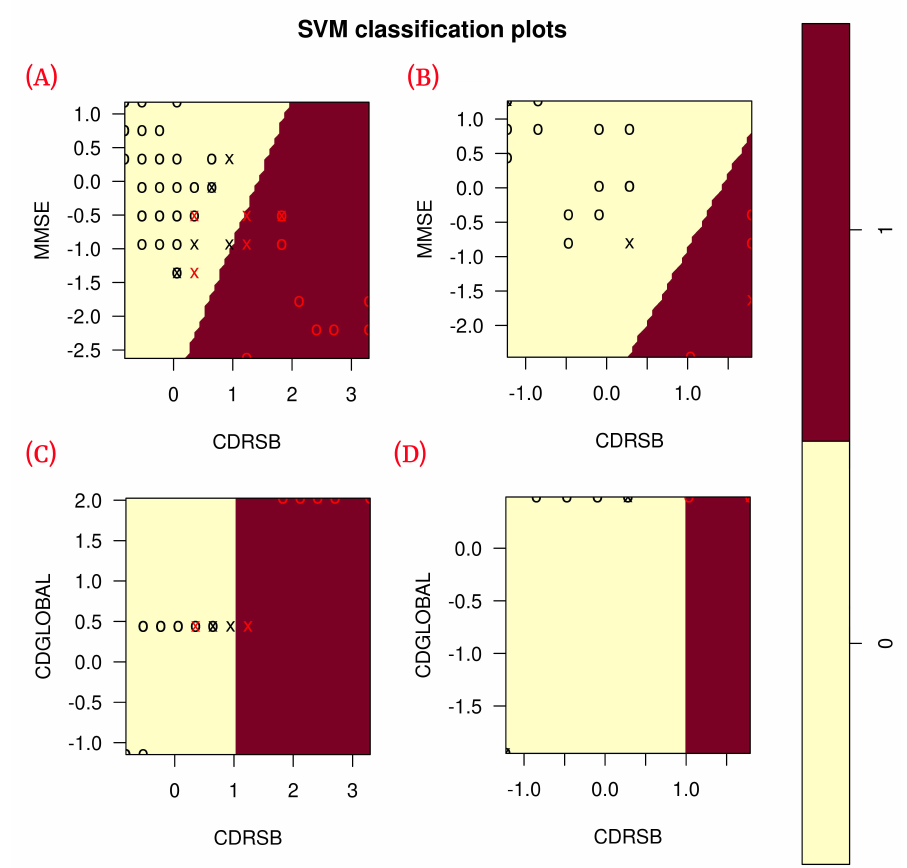
Figure 6. Correlation of the features of each model during training (80% training data) and blind test (20% blind subset). ( A ) Shows the correlation of ADvsMCI/CN-m1 model features in training; ( B ) shows the correlation of ADvsMCI/CN-m1 model features in the blind test; ( C ) shows the correla- tion of ADvsMCI/CN-m2 model features in training; ( D ) shows the correlation of ADvsMCI/CN-m2 model features in the blind test. In these plots, the model support vectors are represented with “X”; the points represented with “O” are the remaining data. The red color classifies the data where Alzheimer’s disease is present, while the black color classifies